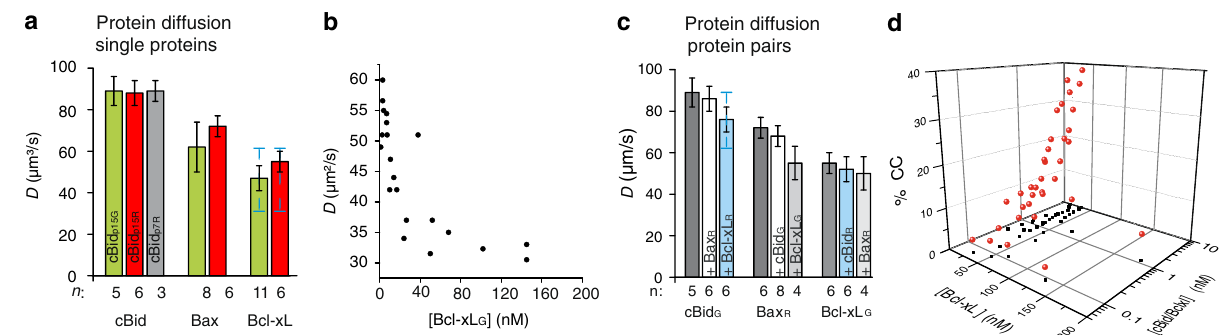
Fig. 2 Quantitative analysis of the interactions between cBid and Bcl-xL in solution. a D of cBid, Bax, and Bcl-xL labeled with Alexa488 or Atto488 ( green columns ), or Alexa633 or Atto655 ( red columns ). The grey column corresponds to cBid p7R . Mean and error bars as s.d. are shown in black; the additional blue error bars for Bcl-xL indicate scattering of D values depending on concentration, n is indicated in the fi gure. b The D of Bcl-xL G in dependence of the protein concentration ( n = 4). c Effect of protein co-incubation on the D of cBid, Bax, and Bcl-xL. Addition of Bcl-xL R , induced a decrease in cBid G diffusion as expected from direct interaction ( n = 3, mean and error bars as s.d. are shown in black ); the additional blue error bar for cBid in presence of Bcl- xL indicates scattering of D values depending on the Bcl-xL/cBid ratio. d The CC between cBid G and Bcl-xL R increased with protein concentration (data as red dots with black shadows in xy , n =